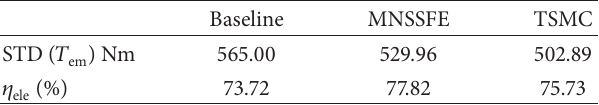
Table 5: Performance comparison for MNSSFE and TSMC with industrial baseline controller.